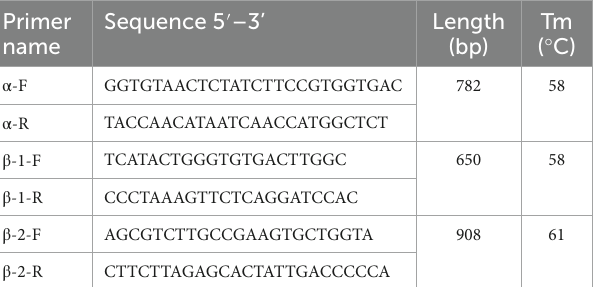
TABLE 2 Hematological parameters and relative lung mass of high- and low-altitude black spotted frogs.